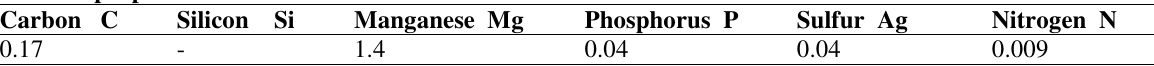
Mechanical properties of material Yield strength in N/mm 2 min for nominal wall thickness Tensile strength in N/mm 2 for nominal wall thickness Elongation % for nominal wall thickness